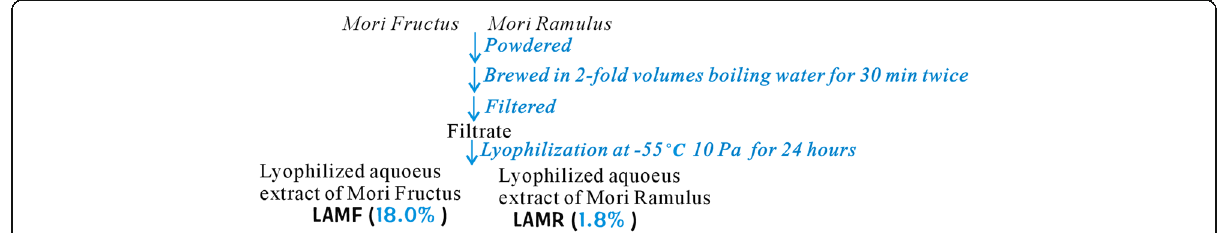
Fig. 2 Preparation of lyophilized aqueous extracts of Mori Fructus (LAMF) and Mori Ramulus